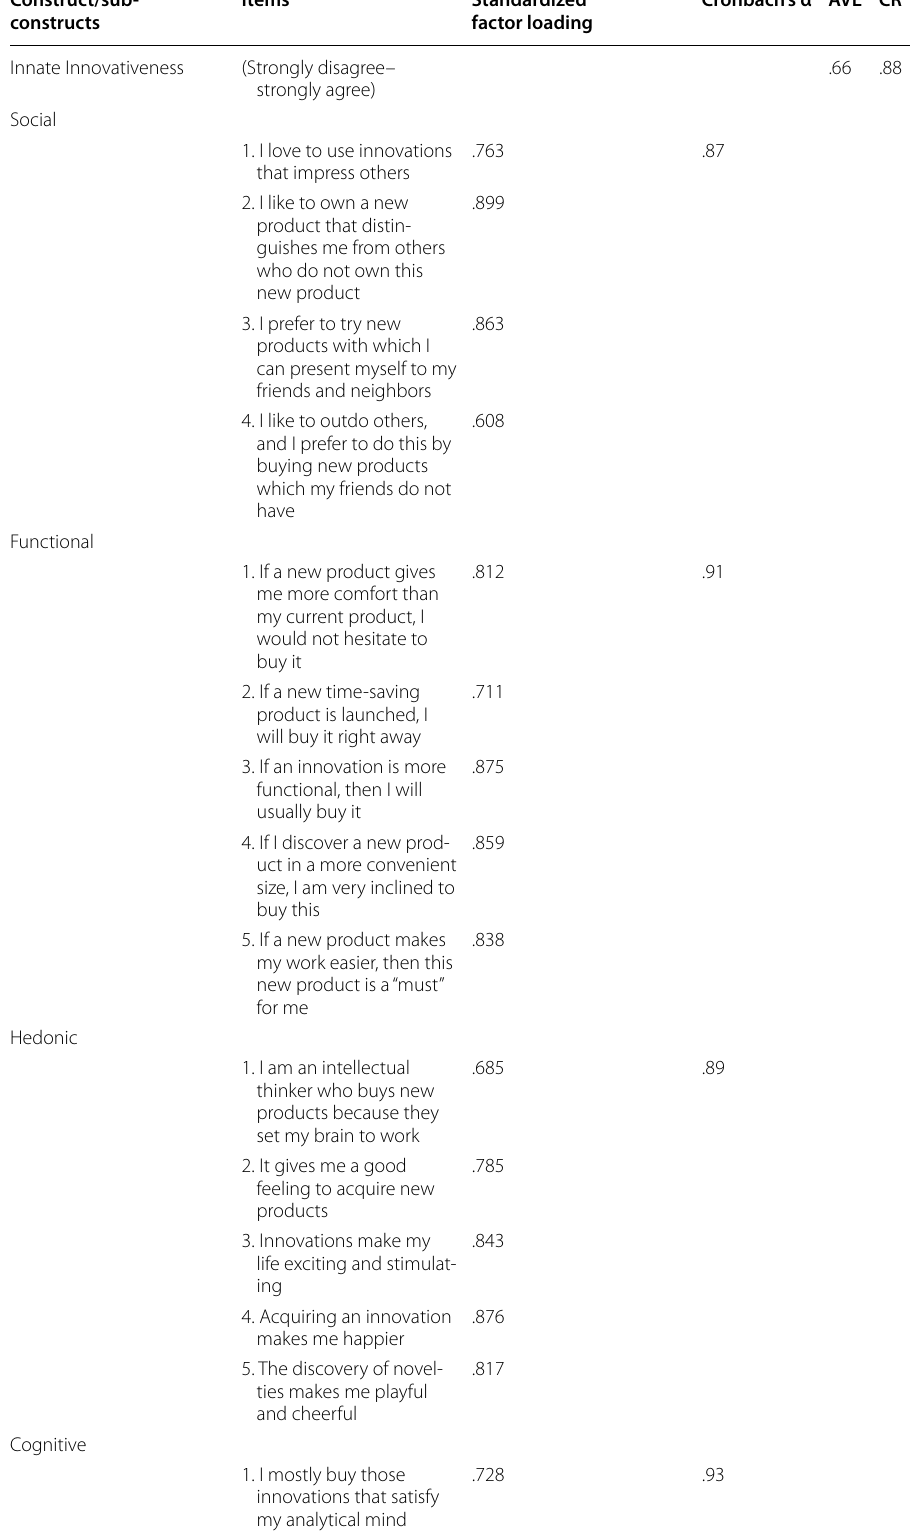
Table 1 Survey instrument measurements Construct/sub-